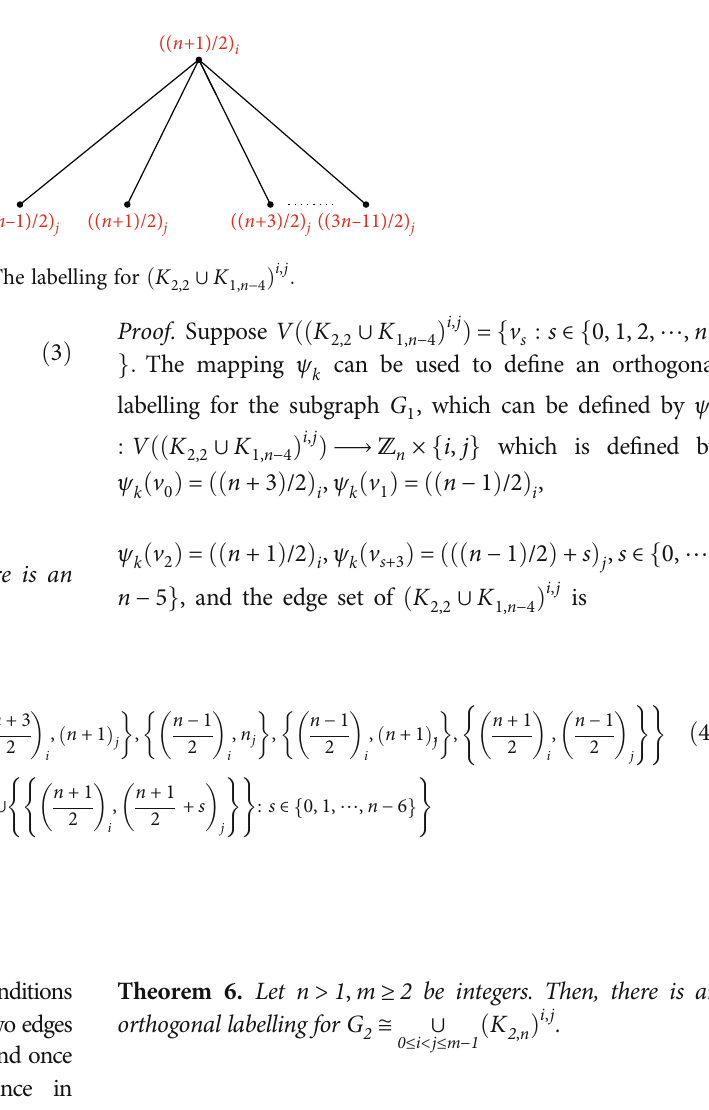
K 0,1 ∪ P 0,2 ∪ K 1,2 : 3,3,3 by 1,3 4 1,3